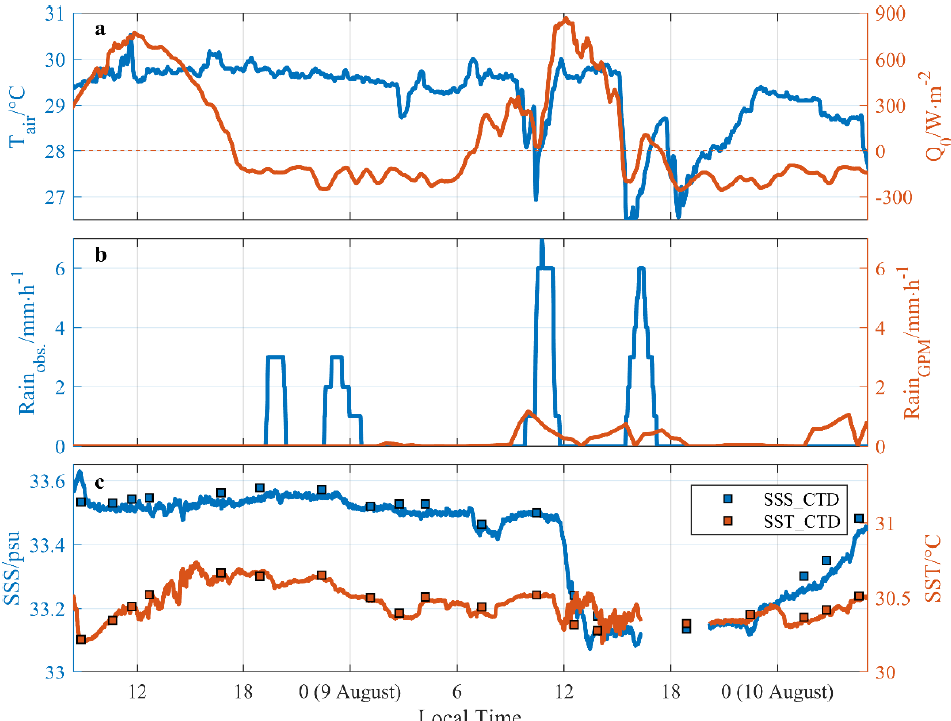
Figure 3. ( a ) Air temperature (blue lines) and net surface heat flux (red lines). ( b ) Rainfall rate from the R/V ’ s AWS (blue lines) and GPM (red lines). ( c ) Near sea surface salinity (blue lines) and temperature (red lines) from SBE-21. Rectangles indicate salinity (blue) and temperature (red) from CTD profiles at ~5 m depth. Vertical axes are scaled by the thermal expansion and haline contraction coefficients, respectively, so that fluctuations of temperature and salinity of equal size imply identical contributions to the density.